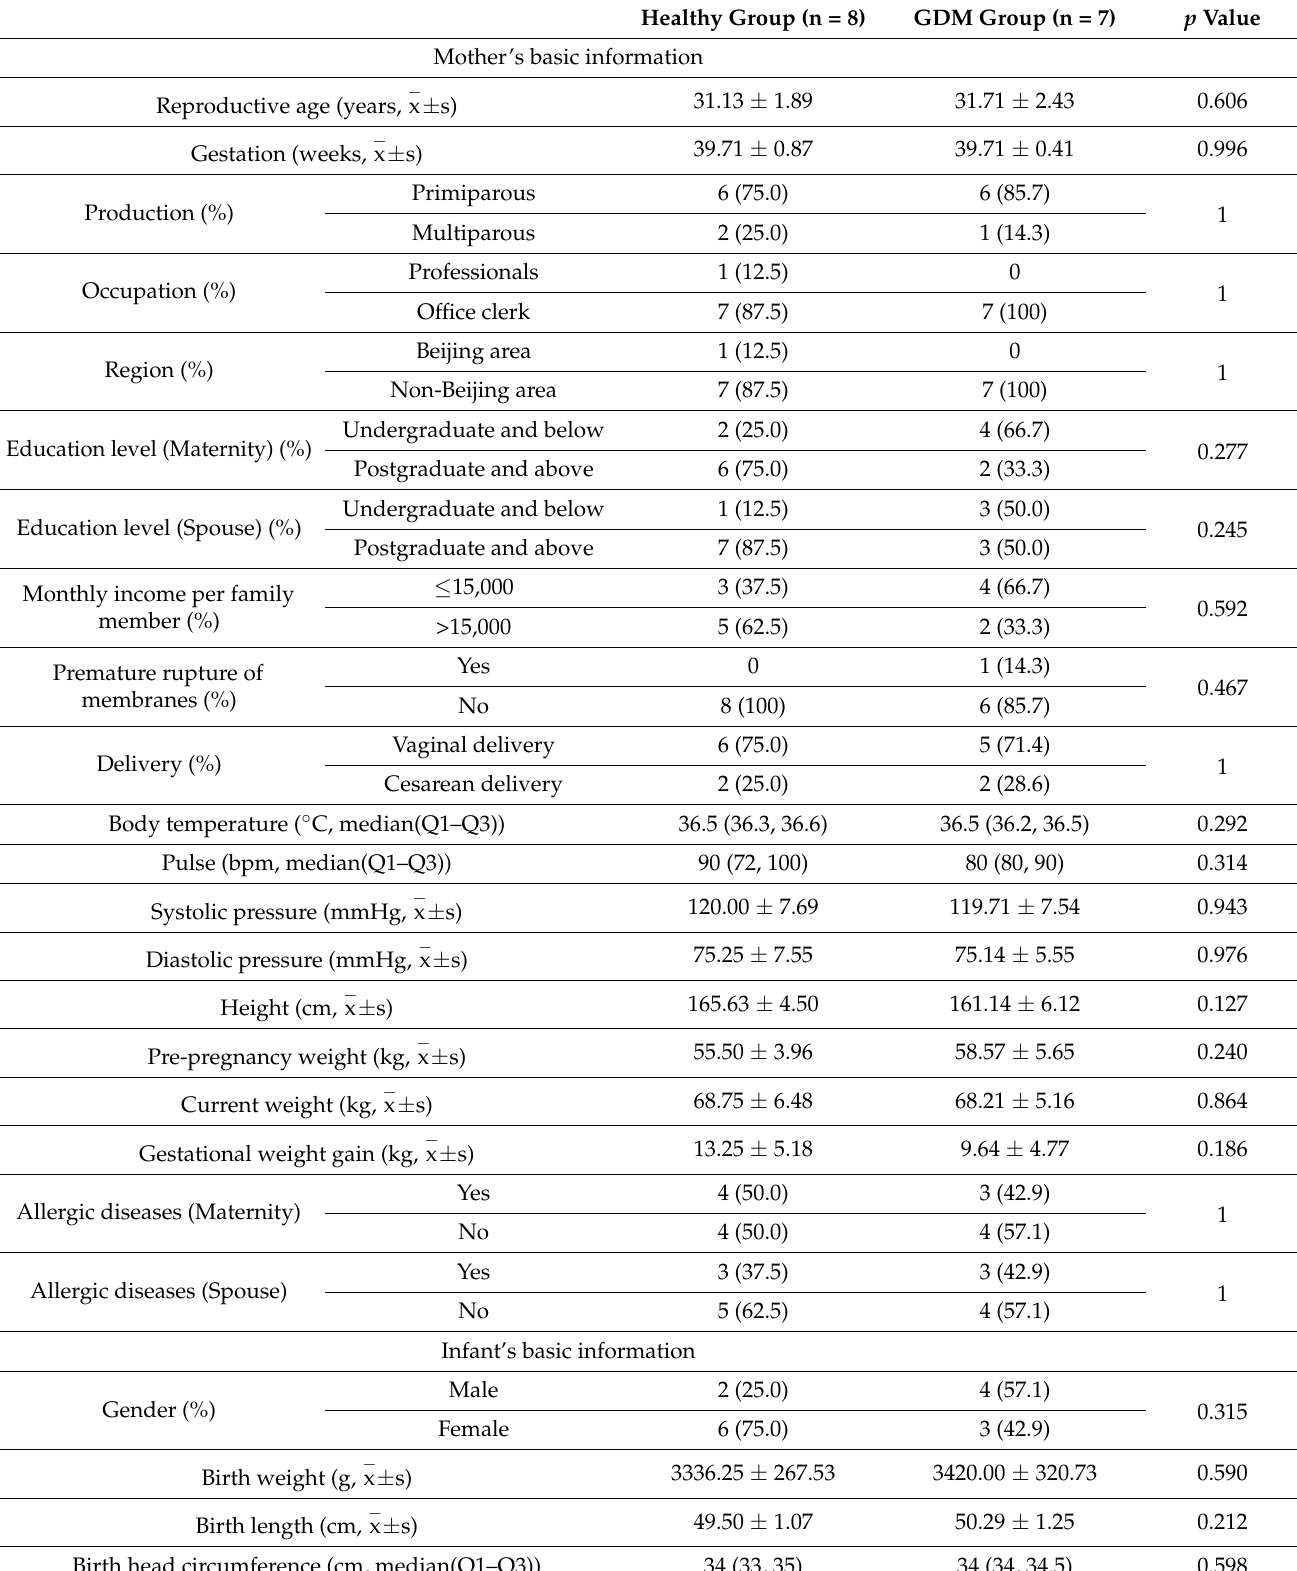
Table 1. Baseline characteristics of subjects in Se + Le +